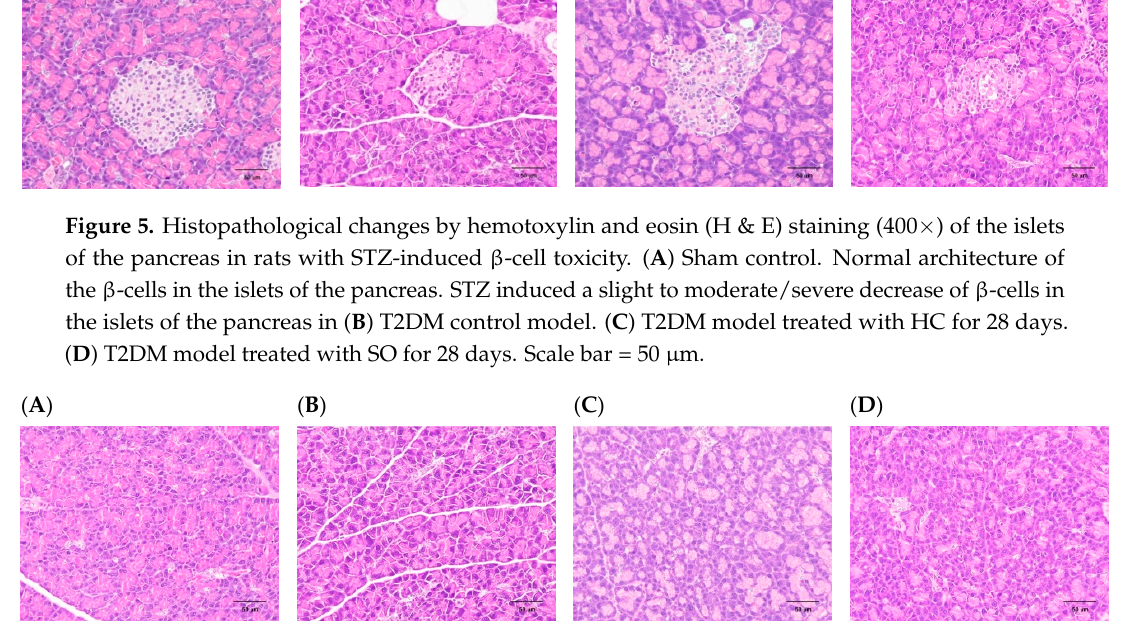
Figure 6. Histopathological changes (H & E staining, 400 × ) of the acinar cells in the pancreas in rats with STZ-induced β -cell toxicity. ( A ) Sham control. Normal architecture of the β -cells in the islets of the pancreas. STZ induced a slight to moderate/severe decrease of β -cells in the islets of the pancreas in ( B ) T2DM control model. ( C ) T2DM model treated with HC for 28 days. ( D ) T2DM model treated with SO for 28 days. Scale bar = 50 µ m. Table 3. Degree of lesions in the pancreas of the T2DM model animals after treatment with HC and SO for 28 days.